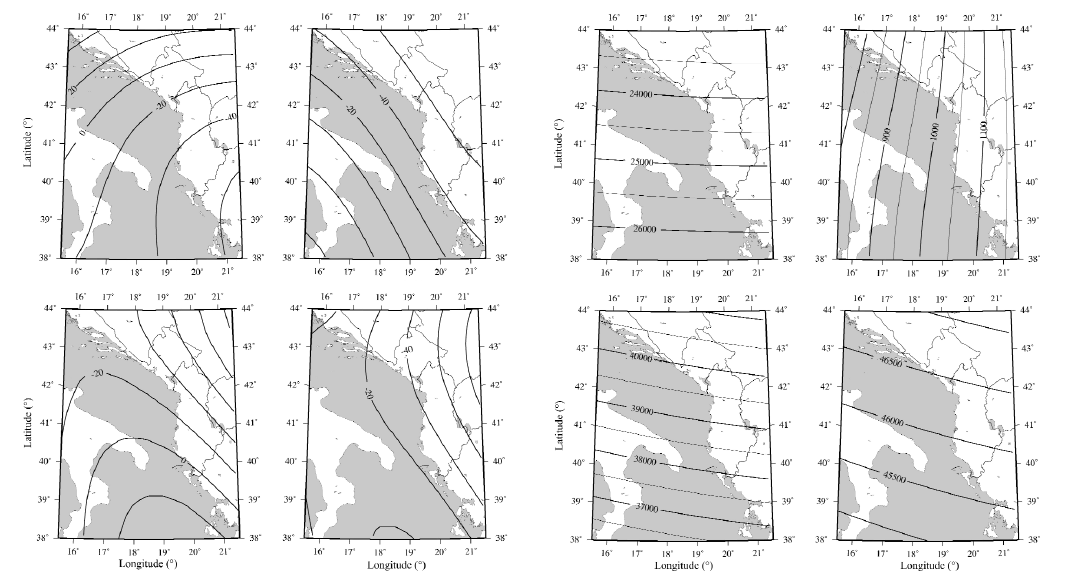
Fig. 4. Maps (in nT) for X (top left), Y (top right), Z (bottom left), and F (bottom right) elements for epoch 2000.0 at sea level obtained from a SCHA model developed on an 8° semiangle